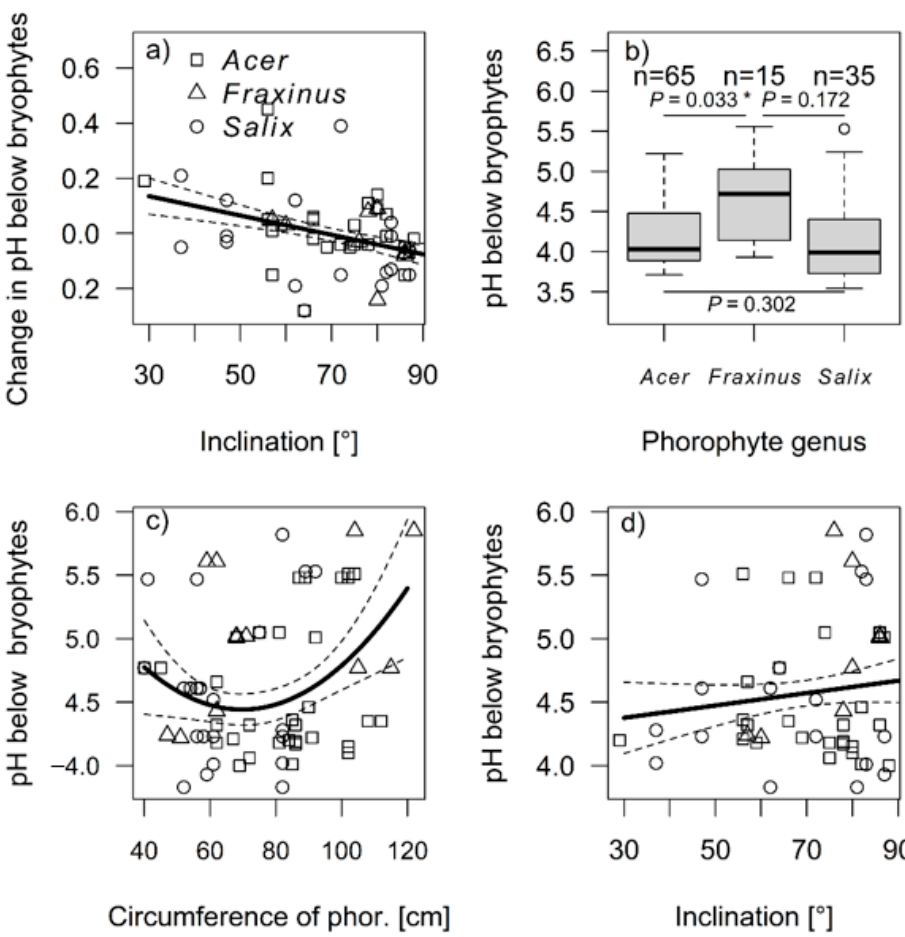
Figure 2. The difference in pH below bryophytes (in comparison to control samples near bryophytes) along the gradient of the inclination ( a ). The pH below bryophytes compared amongst the species of phorophytes ( b ). The pH below bryophytes along the gradient of the circumference of phorophytes with p -values for pairwise comparisons ( c ), and along the gradient of the inclination ( d ). In the scatter plots, the dashed lines represent the 95% CI. The trend curves were created based on generalized linear models with Gamma distribution. The asterisk (*) indicates that the value is significant.